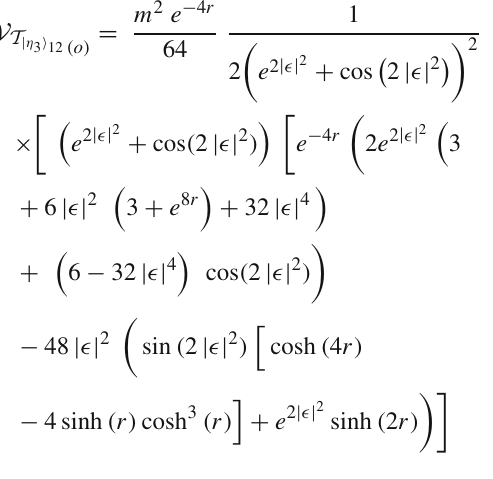
(a) Array Plot for the Table ( 10) showing numer- ical values of D T tabulated in the form of | η 3 (cid:2) 12 ( e ) a matrix for same range of coherent and squeez- ing parameters.